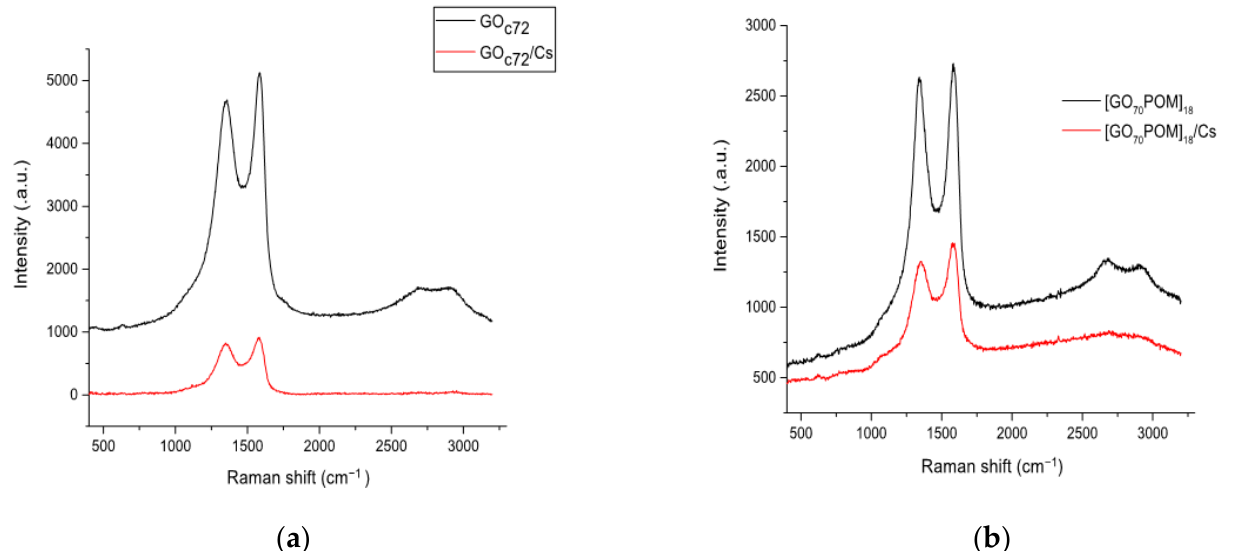
Figure 5. Raman spectra before and after Cs adsorption for ( a ) GO c72 ( b ) [GO 70 POM] 18 .